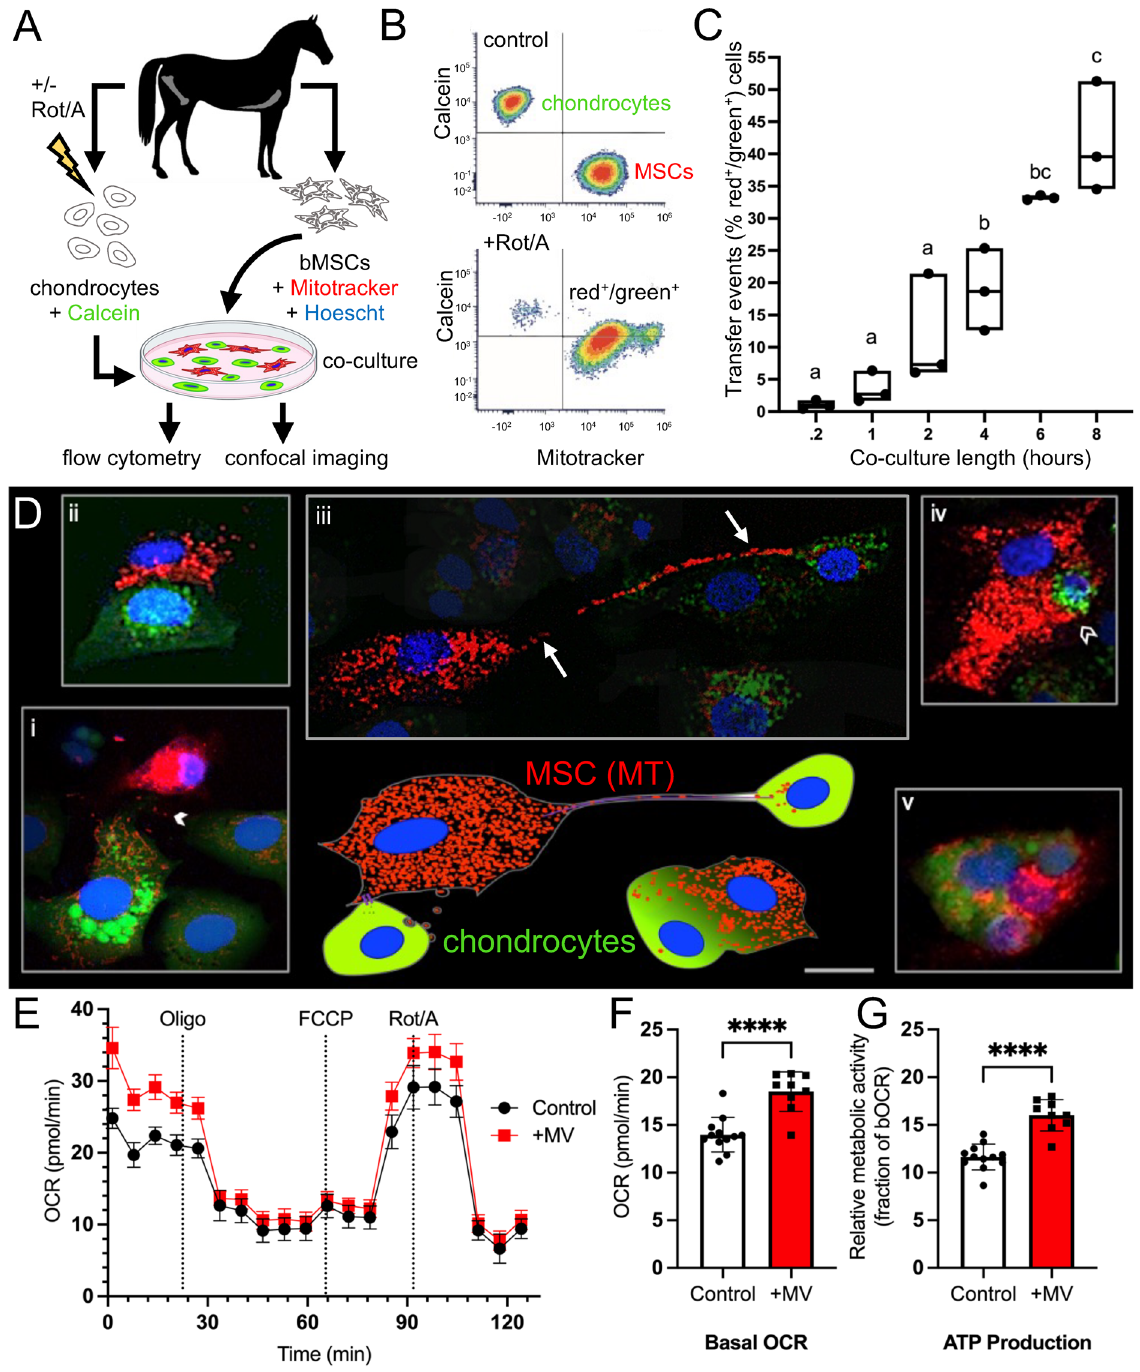
Figure 1. Equine mesenchymal stromal cells (MSCs) transfer mitochondria (MT) to chondrocytes over time and via several modes and increase MT function. ( A ) Experimental design ( B ) Representative flow cytometry plots. Top plot shows results of separately cultured equine chondrocytes stained with Calcein AM (4 mM) and MSCs stained with MitoTracker Deep Red (200 nM) used to set quadrant gates; bottom plot shows red + /green + chondrocytes (upper right-hand quadrant) after rotenone and antimycin (Rot/A; 0.5 μM/0.5 μM) stimulation and co-culture with MSCs. ( C ) MT transfer (% red + /green + cells) increases with length of co-culture, n = 3. ( D ) Schematic (bottom center) depicting observed modes of MT transfer from MSCs (red MT, blue nuclei) to chondrocytes (green cytoplasm, blue nuclei) alongside corresponding confocal microscopy images (i-v), taken up to 8 h after initiation of co-culture, stained as above with the addition of Hoechst (5 mg/L, blue) to MSCs before co-culture; representative images of (i) likely gap junction-mediated microvesicle (MV, arrowhead) transfer, (ii) close cellular contact without apparent transfer demonstrating the broad range of observed cell–cell interactions, (iii) possible tunneling nanotubule-mediated filopodial (arrows) transfer, (iv) apparent phagocytosis-like event (open arrowhead), (v) cell fusion event. Note that in (i) and (iii), contrast in surrounding cells was decreased 10–20% to highlight the mentioned interaction; Bar ≅ 10 µm. ( E ) Equine chondrocyte oxygen consumption rate (OCR) during real- time microscale respirometry (Seahorse MT stress test) with and without MV treatment. ( F ) Respirometry data shows MV treatment increases equine chondrocyte basal OCR. ( G ) ATP production in equine chondrocytes increases with MV